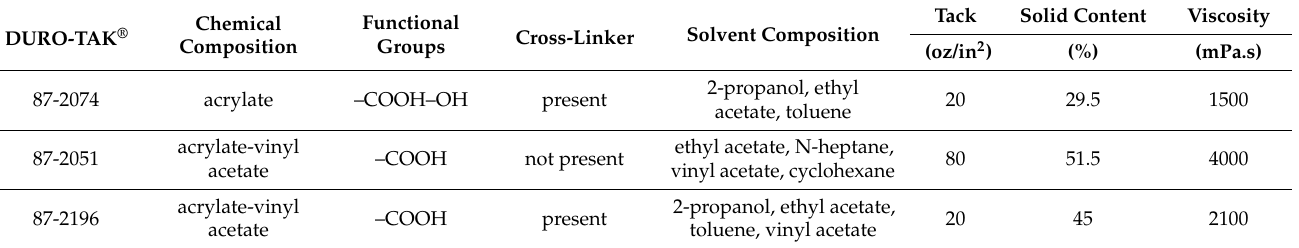
Table 3. Properties of DURO-TAK ® 87-2074, DURO-TAK ® 87-2051, and DURO-TAK ® 87-219.